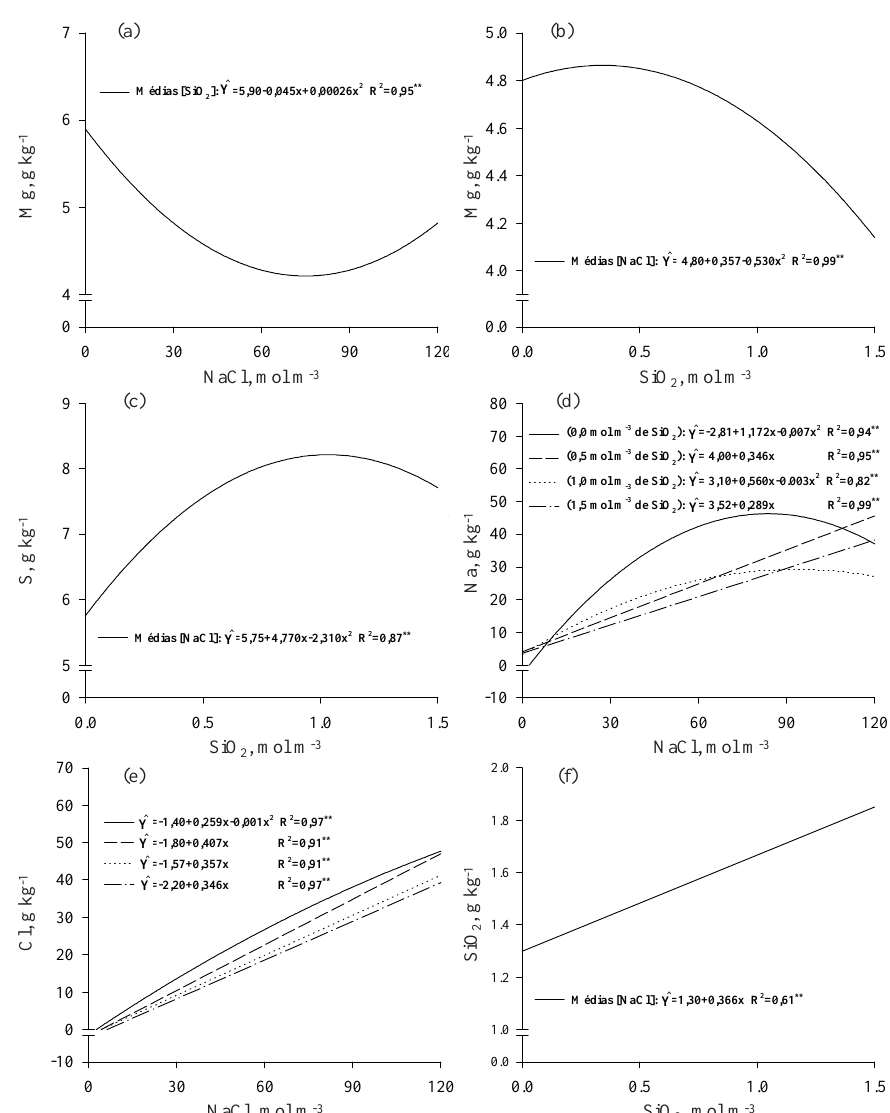
Figura 3. Teores de Mg (a, b), S (c), Na (d), Cl (e) e SiO concentrações de NaCl e de SiO